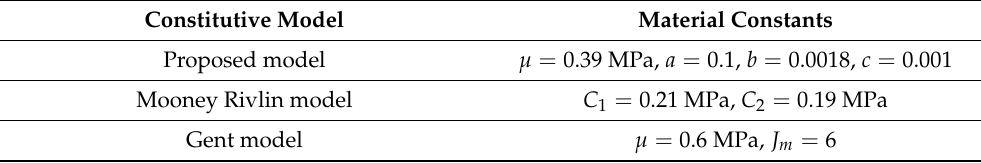
Table 2. Material parameters of proposed (19), Mooney Rivlin (20), and Gent (20) material models for Oppo.